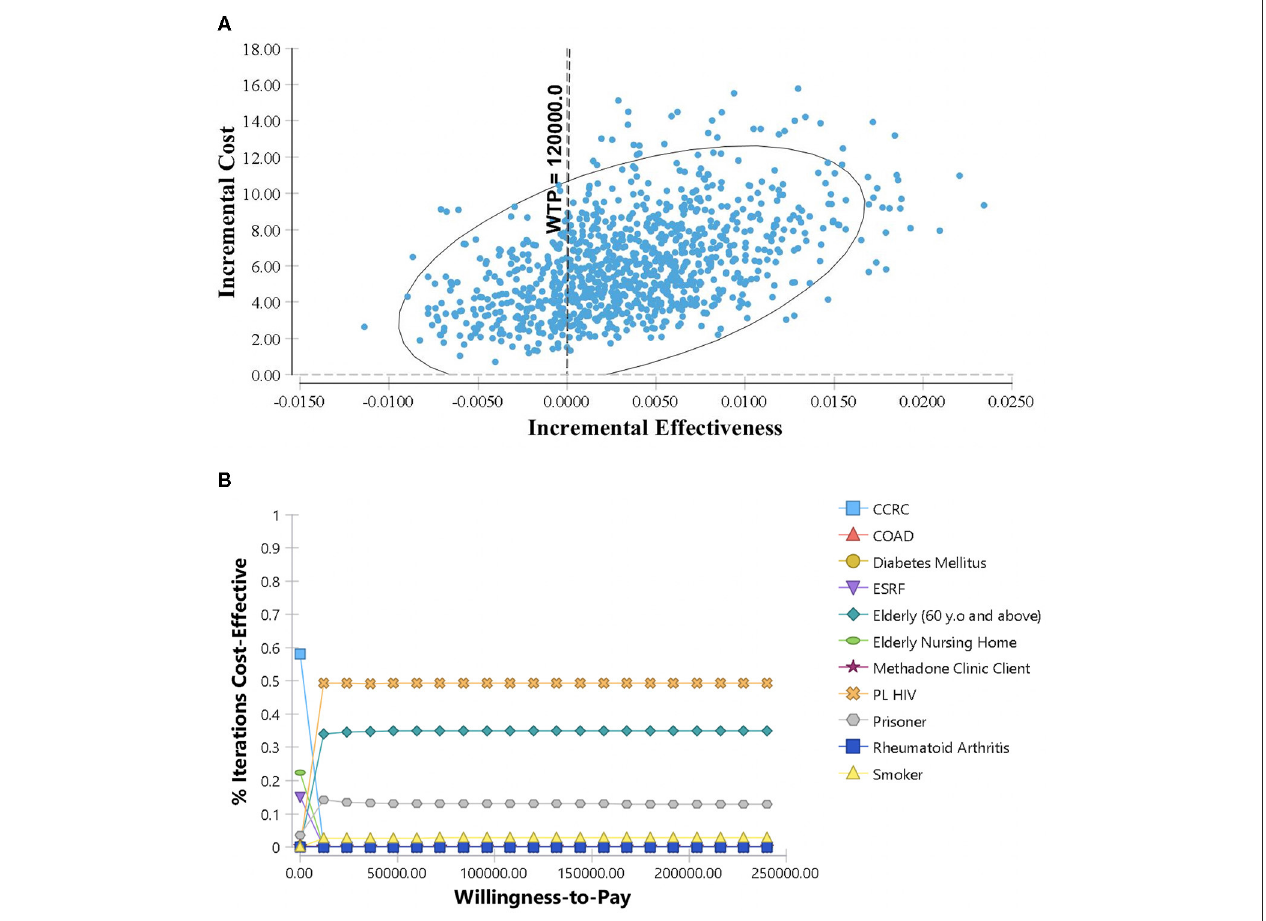
FIGURE 4 | Probabilistic Sensitivity Analysis for TB screening among high-risk groups: (A) Scatter plot of incremental cost and incremental effectiveness for PL HIV vs. prisoners; (B) Cost-Effectiveness Acceptability Curve for high-risk groups TB screening. Each parameter in the model is assigned with suitable statistical distributions and allowed to diverse based on the corresponding distributions. The results of 1,000 simulations are shown in the cost-effectiveness plane as scatter plot of incremental cost and incremental effectiveness for PL HIV vs. prisoners. The Cost-Effectiveness Acceptability Curve (CEAC) shows the cost-effectiveness of screening among high-risk groups at various level of willingness to pay